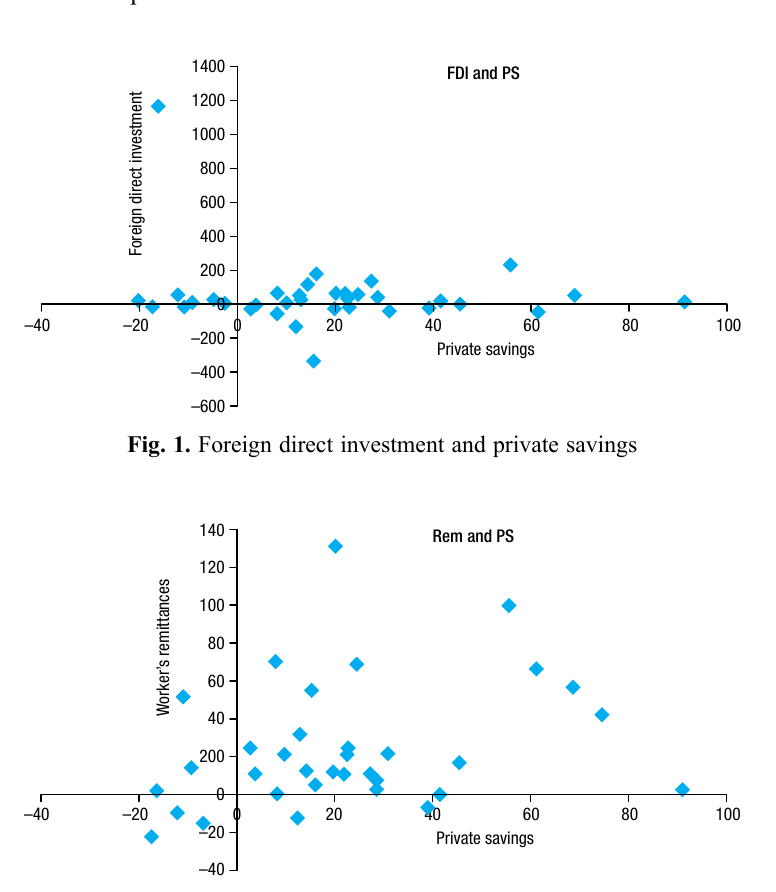
Fig. 2. Worker’s remittances and private